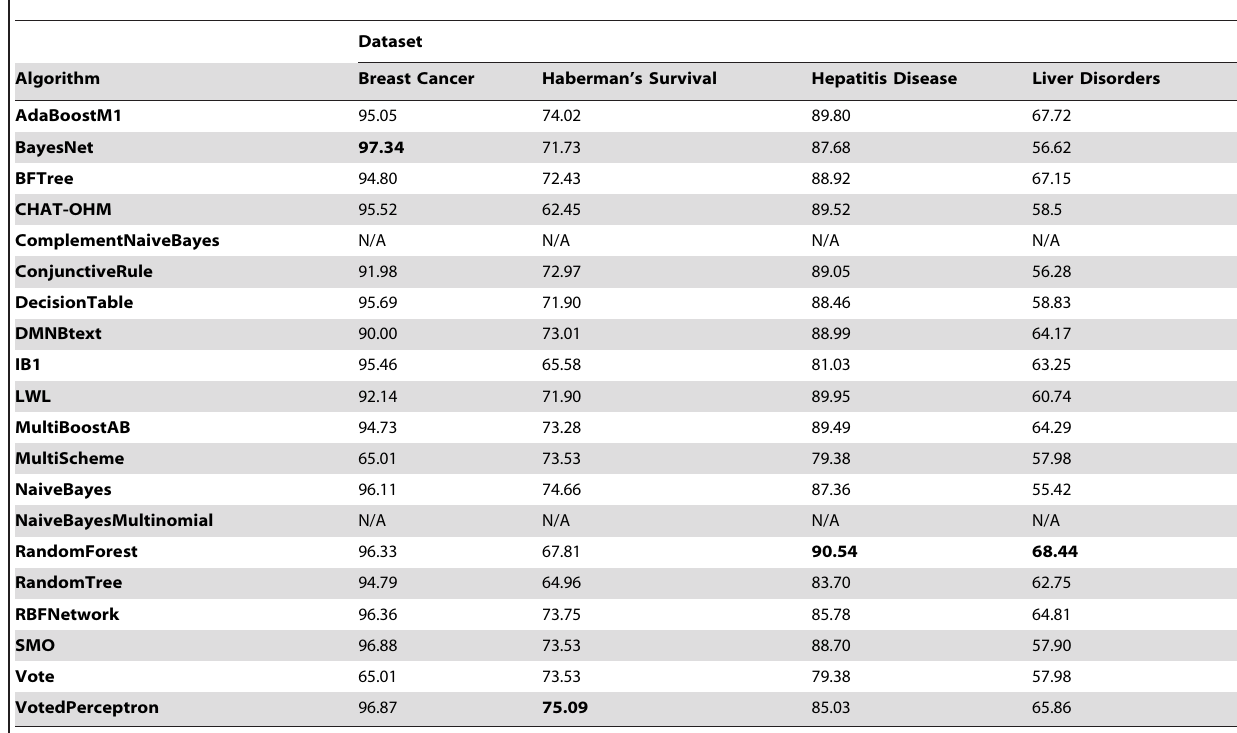
Table 4. Clasification accuracy comparison (%) normalized data.